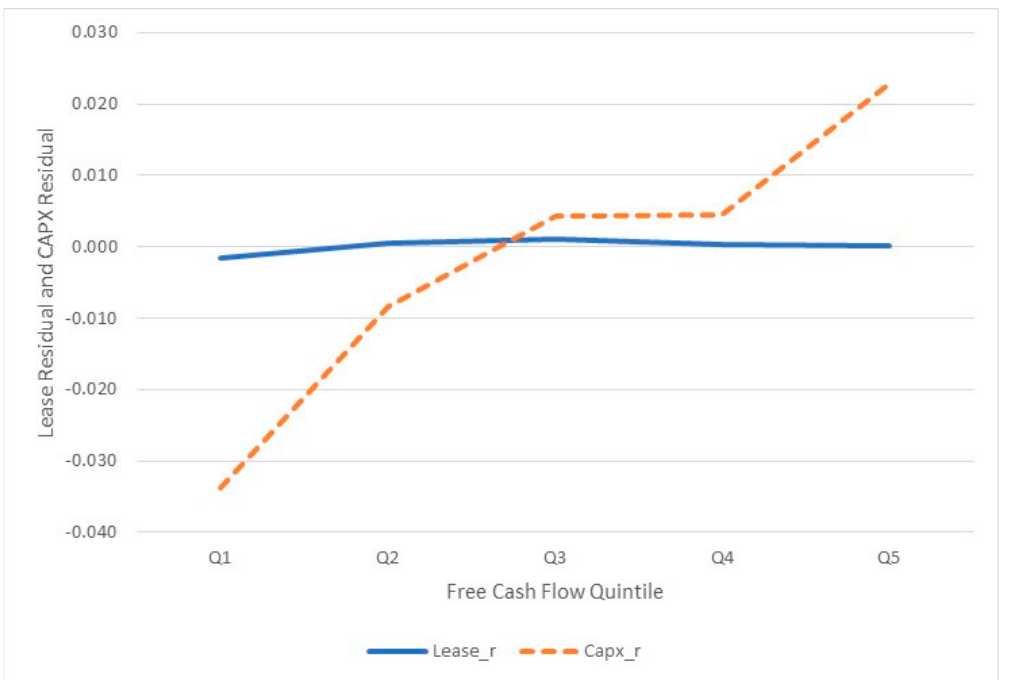
Figure 1. Lease Residuals and CAPEX Residuals by Free Cash Flow